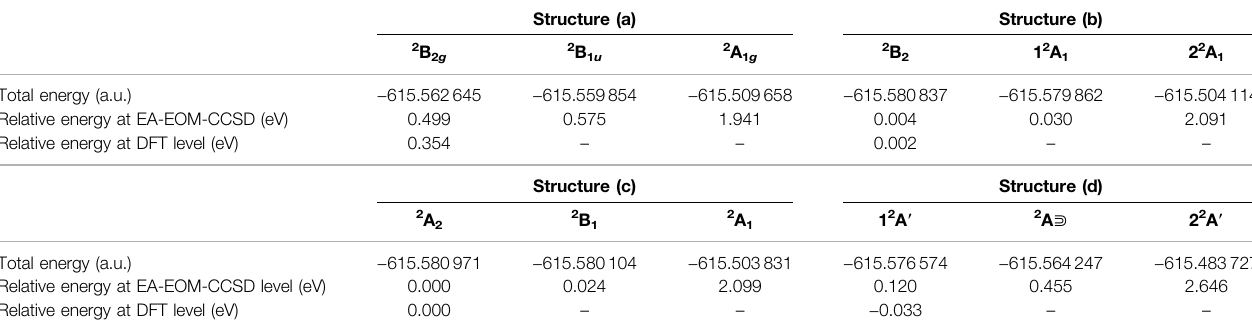
TABLE2| Thetotalandrelativeenergiesofthelow-lyingstatesofthestructures(a)to(d)ofLi@C 16 shownin Figure1 ,computedattheEA-EOM-CCSDleveloftheoryatthe optimized geometries reported [i.e., optimized via EA-EOM-CCSD for structures (a), (b) and (c) and via DFT for structure (d)]. Also shown are the relative energies of the ground states of structures (a) to (d) calculated at the DFT level of theory at the geometries optimized on the DFT level. The data of structure (a) are taken from (Yang and Cederbaum, 2021b).